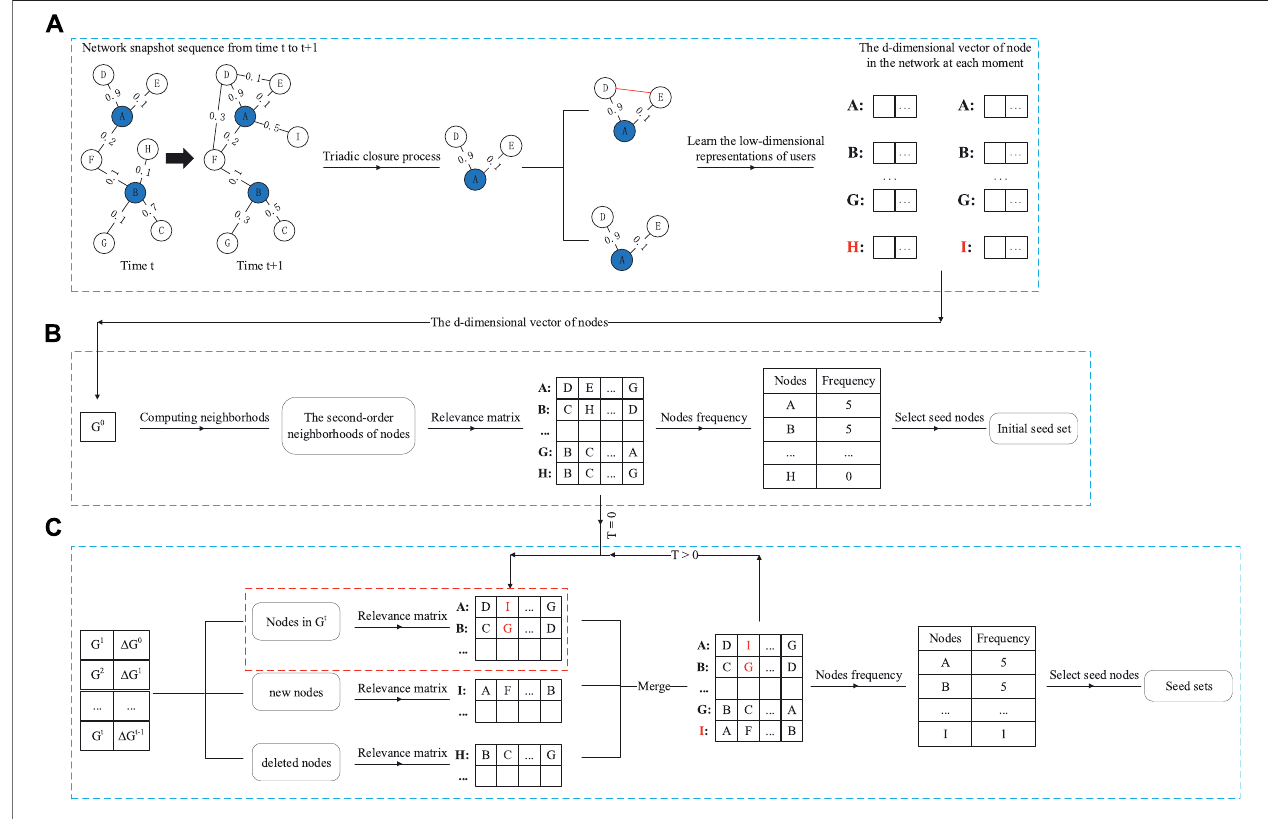
FIGURE 1 | Overall framework of DIMNRL. (A) Getting the low-dimensional vector representation of the dynamic network, (B) obtaining the initial seed set with maximum in fl uence from the initial network, and (C) incrementally updating seed nodes to gain the seed sets of the networks at all times.